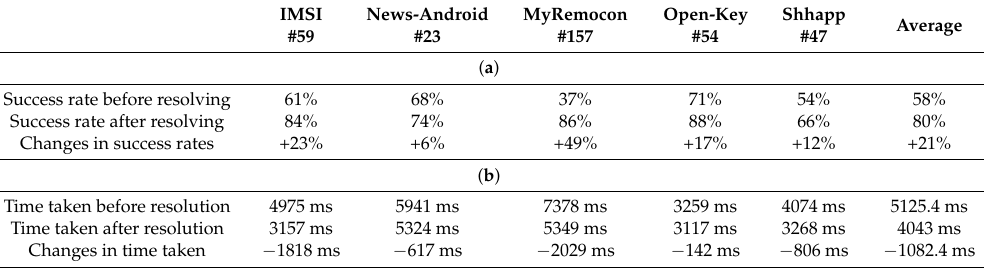
Table 2. Comparison of efficiency: application with vs. without bad symptoms ( a ) Comparison of scenario success rates before and after resolving bad symptoms, ( b ) Comparison of time taken to perform usage scenarios before and after resolving bad